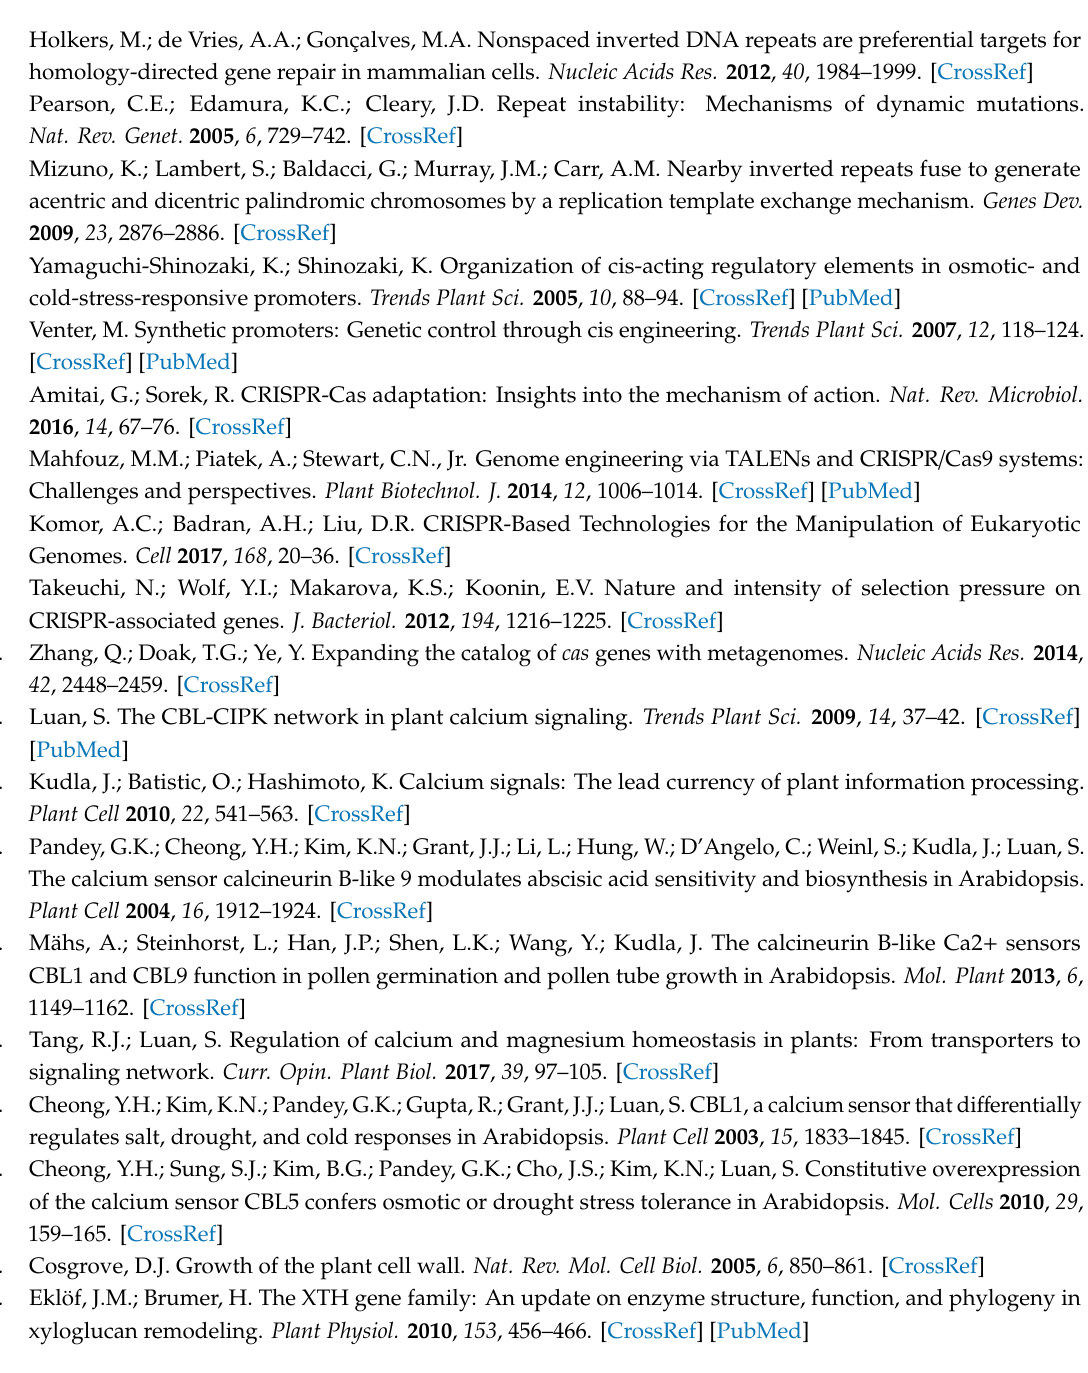
Table S1: All identified IRSs and their locations in Arabidopsis genome. Table S2: Primers used for construction of expression vectors and transgenic plant analysis. Table S3: Primers used for RT-qPCR in this study. Figure S1: Location of T-DNA insertion in the mutant